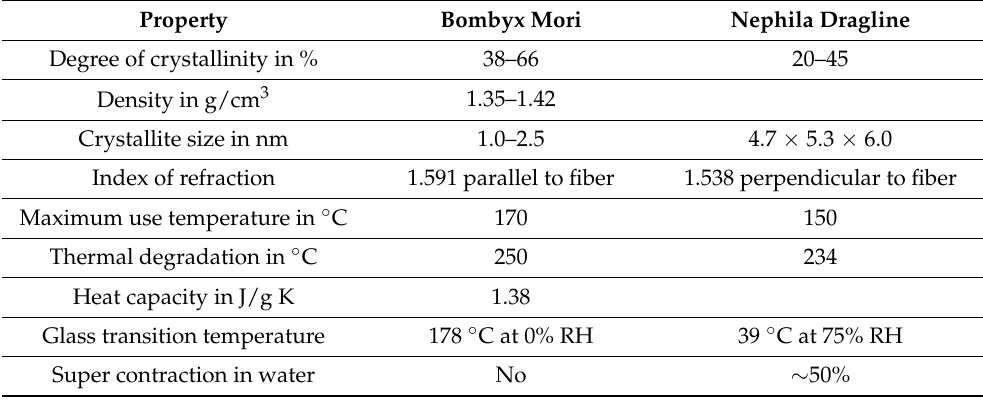
Table 4. Properties of mulberry and Nephila dragline silk [66,69–74].